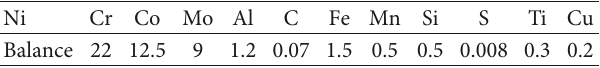
Table 1: Chemical composition of Inconel 617 alloy